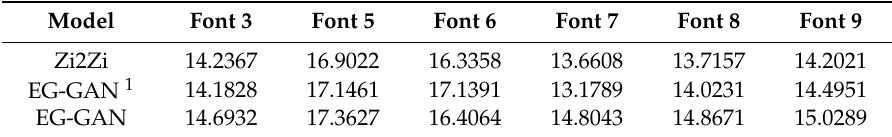
Table 5. Comparison of PSNR metrics for each single